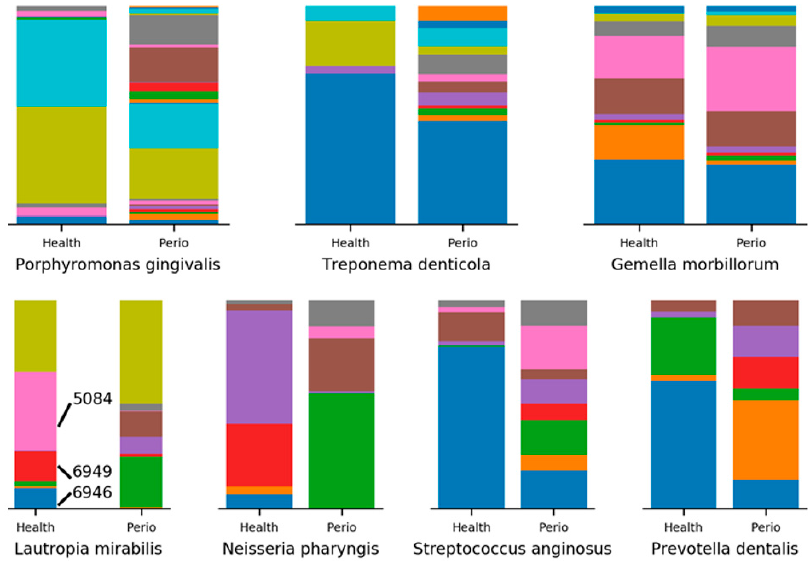
Figure 4. Minimum entropy decomposition (MED) analysis of 9 OTUs with distinct nodes. Examples of subgingival bacteria for which differences in both the number and distribution of MED nodes (e.g., potential subspecies) are seen in periodontal health versus